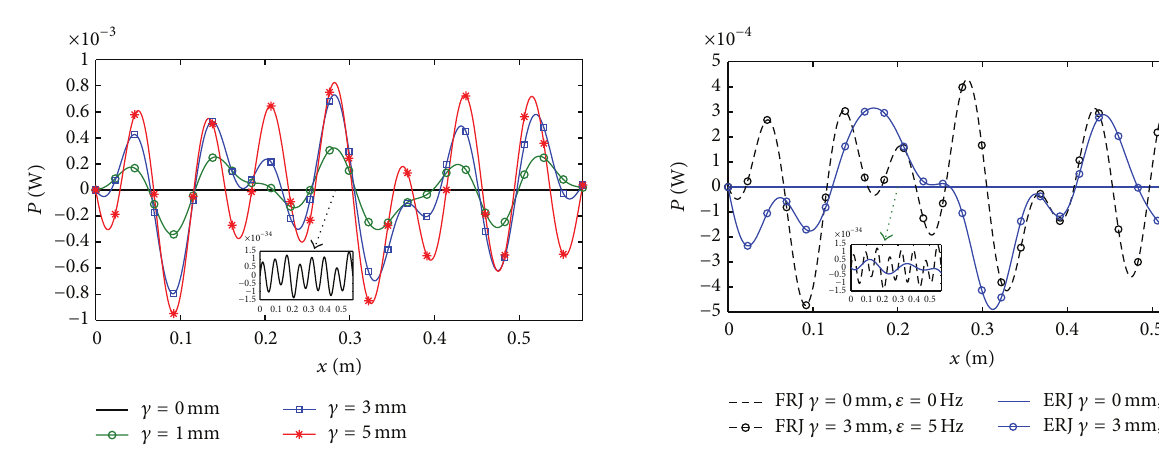
Figure 4: Vibration power flow of the FRMEJ with different disturbance amplitudes.